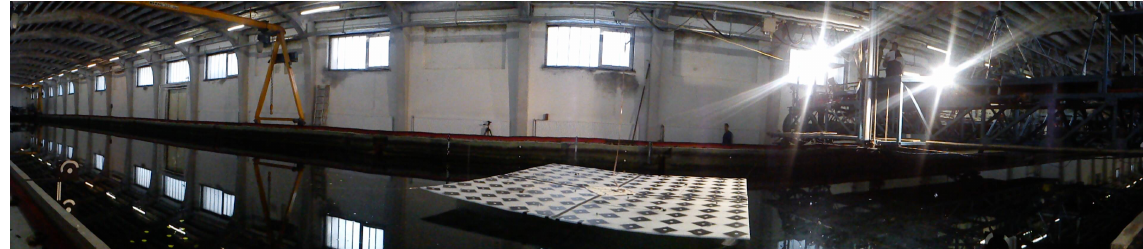
Figure 1: Vienna Model Basin. The central part is occupied by the observed platform. Camera system is placed next to the lamps. Filter (KF) to detect their anomalous behaviour. The anomalous behaviour meaning: (i) wrong centroiding due to glittering effect, (ii) loss of points due to temporary lack of illumination (point facing away the camera, (iii) loss of points due to temporary oc- clusions (cf. Fig. 2).